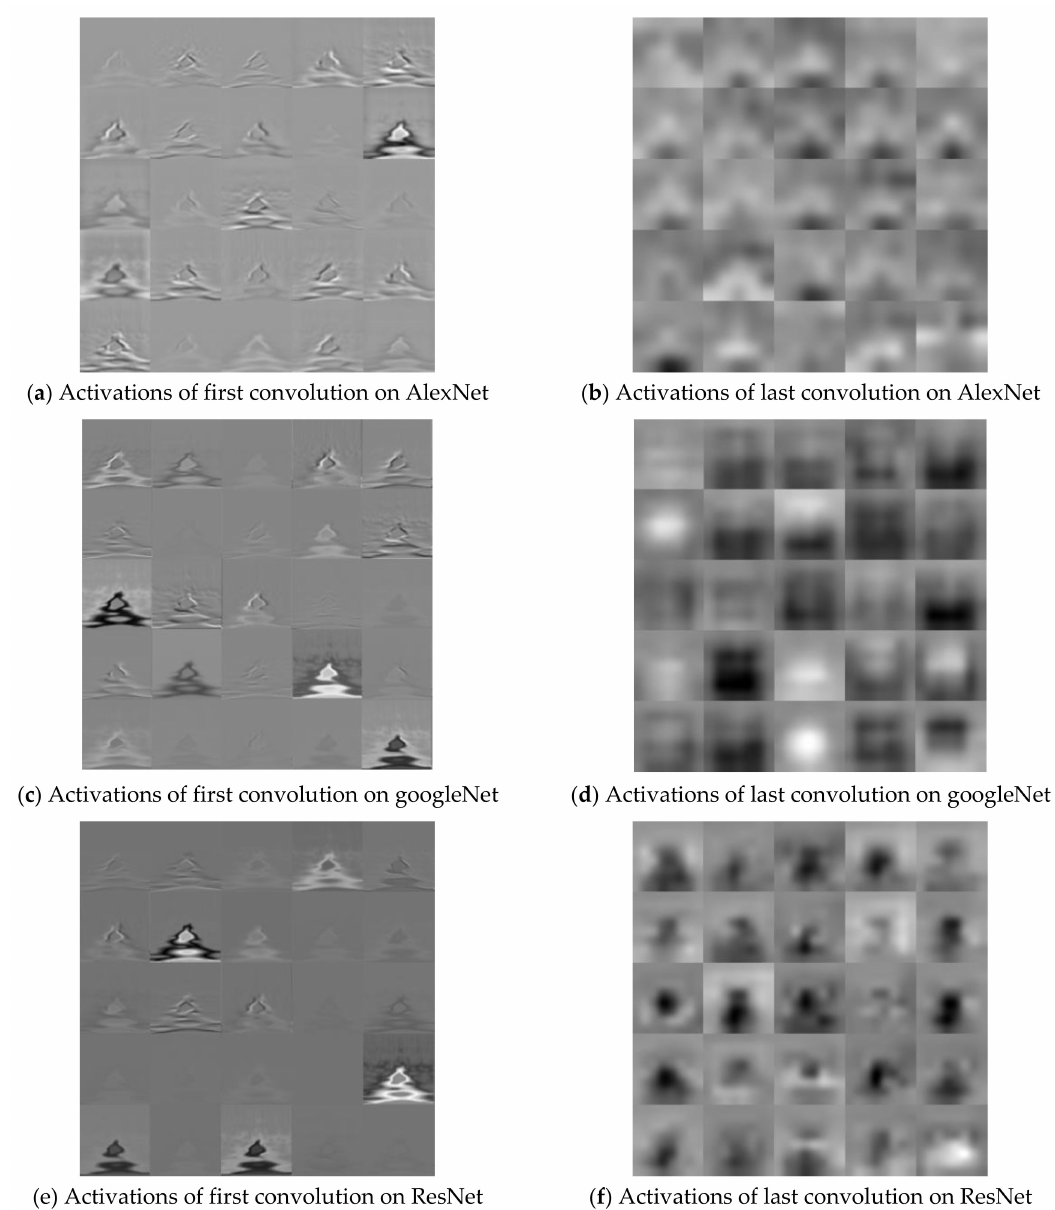
Figure 15. Comparison of the activations of the first and last convolutions in